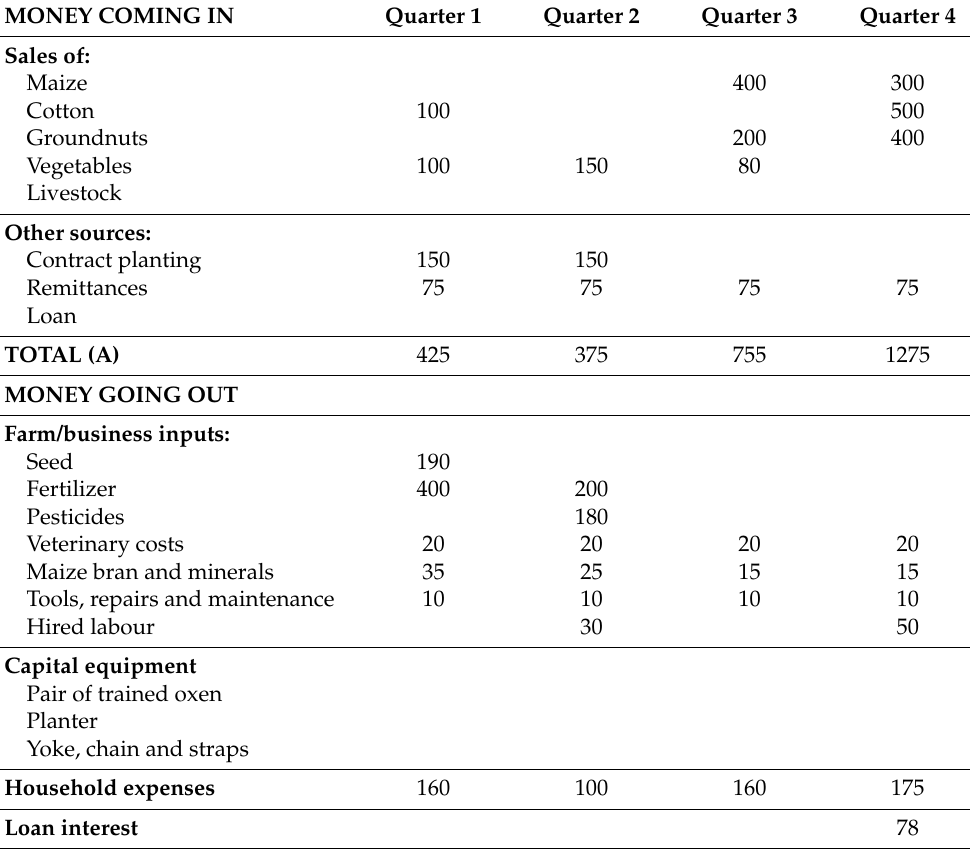
Table 5. A cash flow budget for the four quarters of the